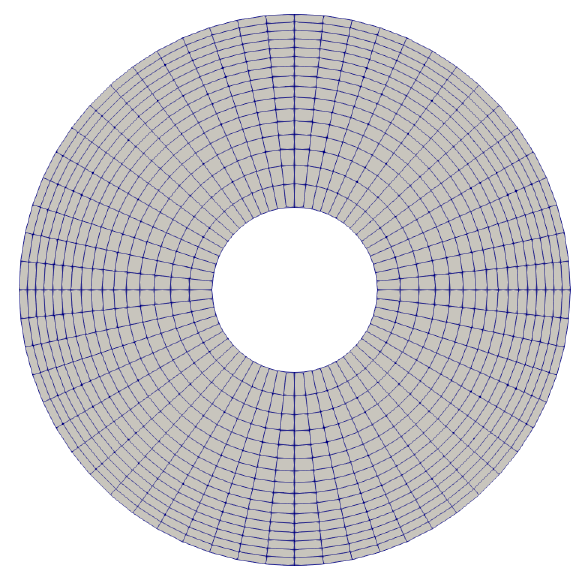
Figure 3. Velocity triangles upstream and downstream of the rotor row.